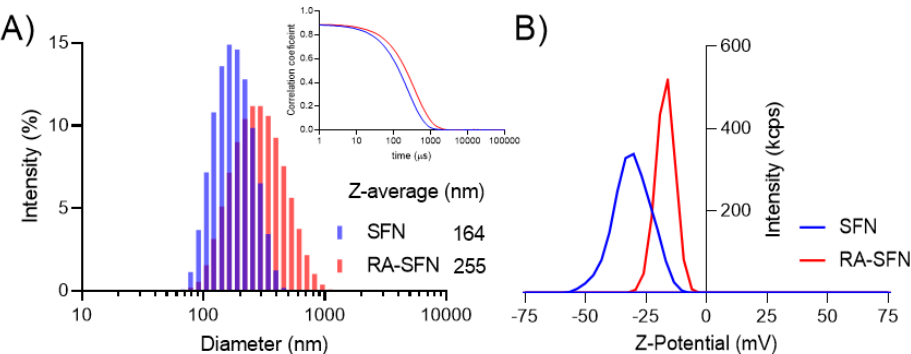
Figure 1. ( A ) Size distribution based on the intensity of SFNs and RA-SFNs with an insert of the correlation coefficient for the two systems and ( B ) Z-potential distribution based on the intensity of SFNs and